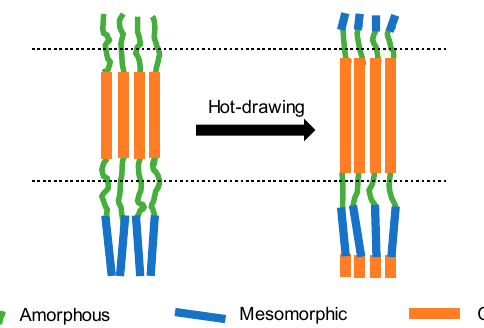
Figure 9. Schematic diagram of possible phase transitions in F-III fibers before and after hot-drawing treatment in Sc-CO 2 .